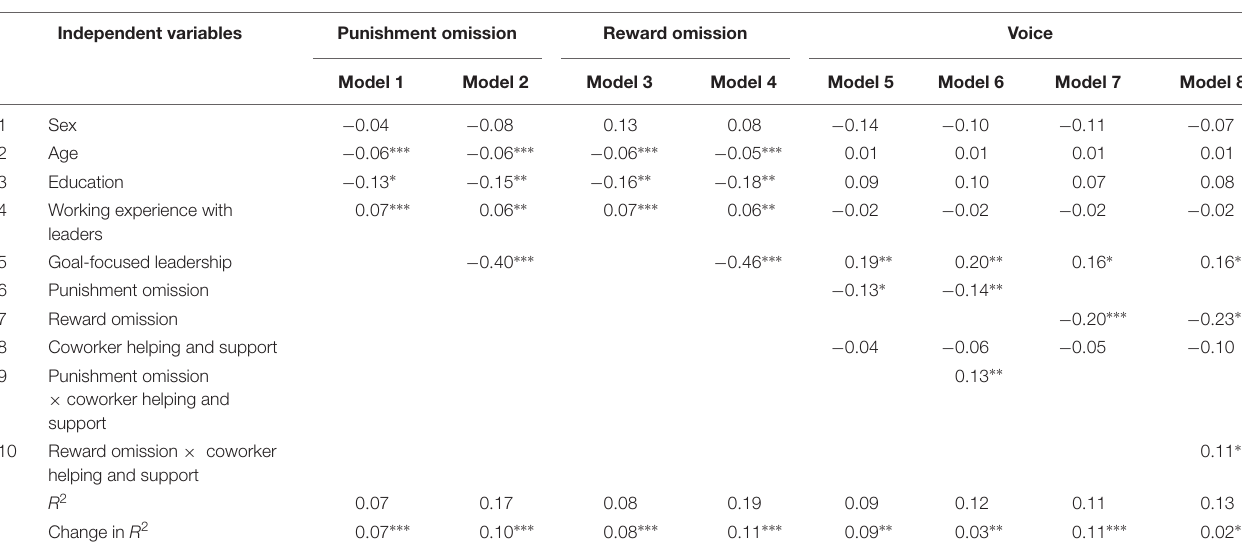
TABLE 3 | Results of regression